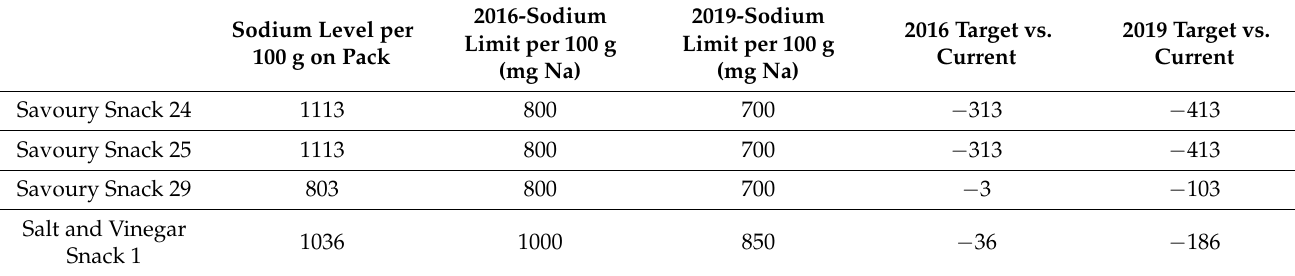
Table 4. Varieties failing to meet both 2016 and 2019